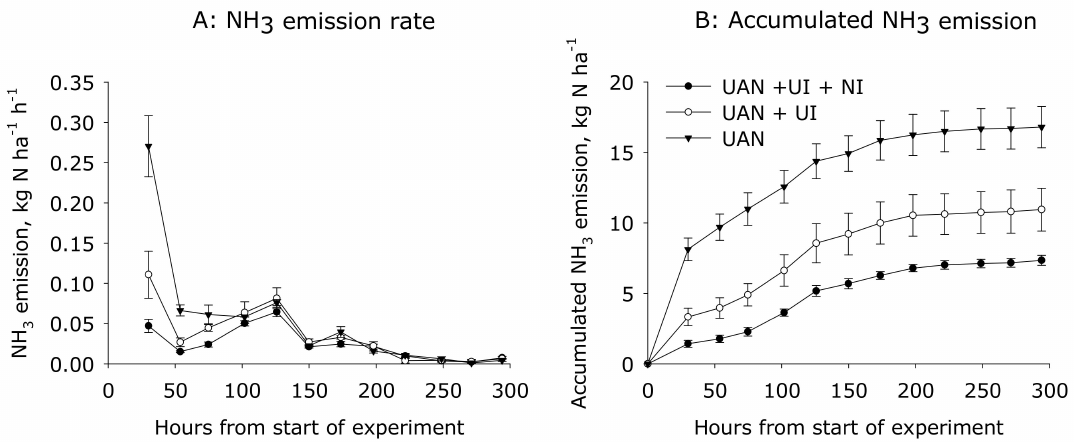
Figure 5. Experiment three where NH 3 emission was measured in August. A: NH 3 emission rate. B: accumulated NH 3 emission. The treatments were UAN; UAN without additives, UAN + UI; UAN mixed with urease inhibitor (UI) or UAN + UI + NI; UAN mixed with UI and nitrification inhibitor (NI) (Error bars: SE, n =